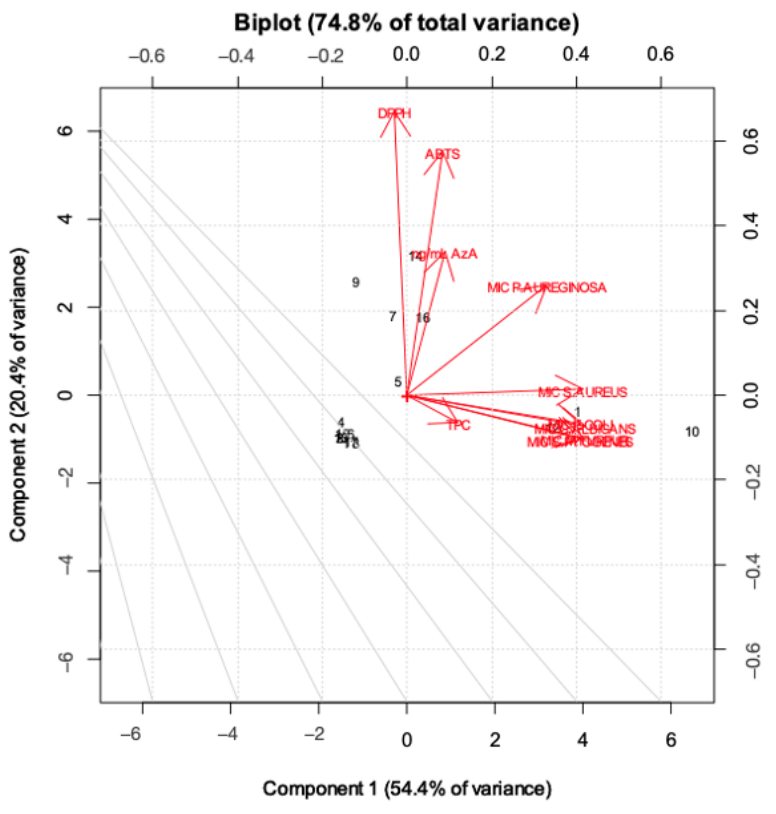
Figure 6. Biplot of the first two principal components, built using scores and loadings.